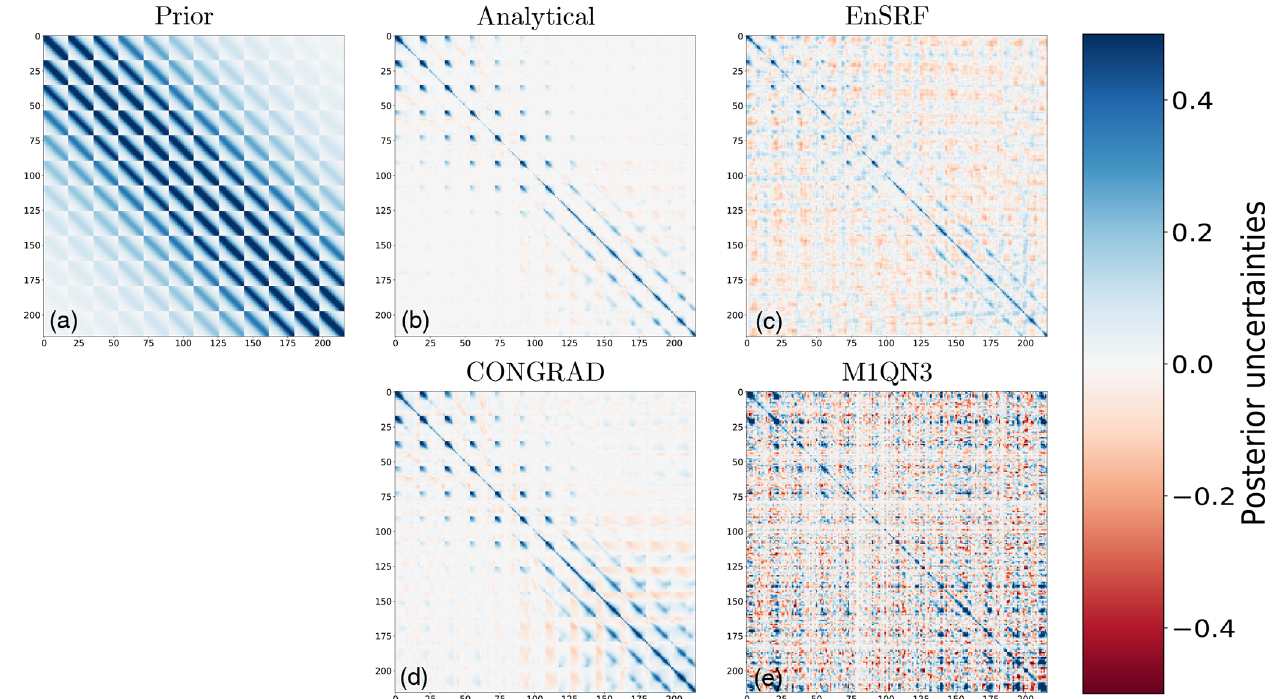
Figure 7. Prior (a) and posterior (b–e) uncertainty matrices for analytical, EnSRF, variational with CONGRAD and variational with M1QN3 (from top to bottom, middle and right columns), with the same set-up as in Fig. 5. All matrices are reported with unitless values; i.e., a “1” on the diagonal corresponds to a 100%